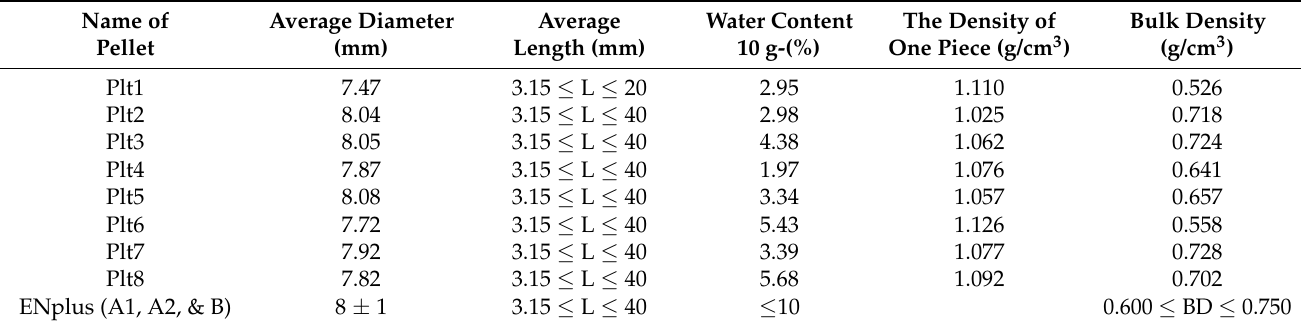
Table 2. Average diameter, length, water content, and density of seaweed pellets produced in this project. The last row presents the specifications of standard wood pellets [15].